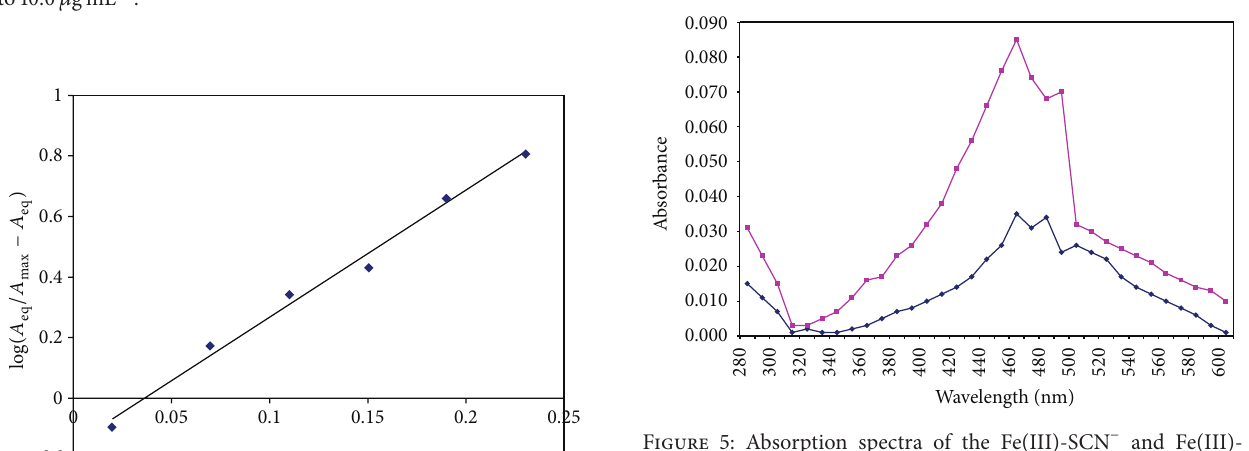
Figure 5: Absorption spectra of the Fe(III)-SCN − and Fe(III)- SCN − -[AMIYTP] + complexes (concentration of amitriptyline = 5 𝜇 gmL −1